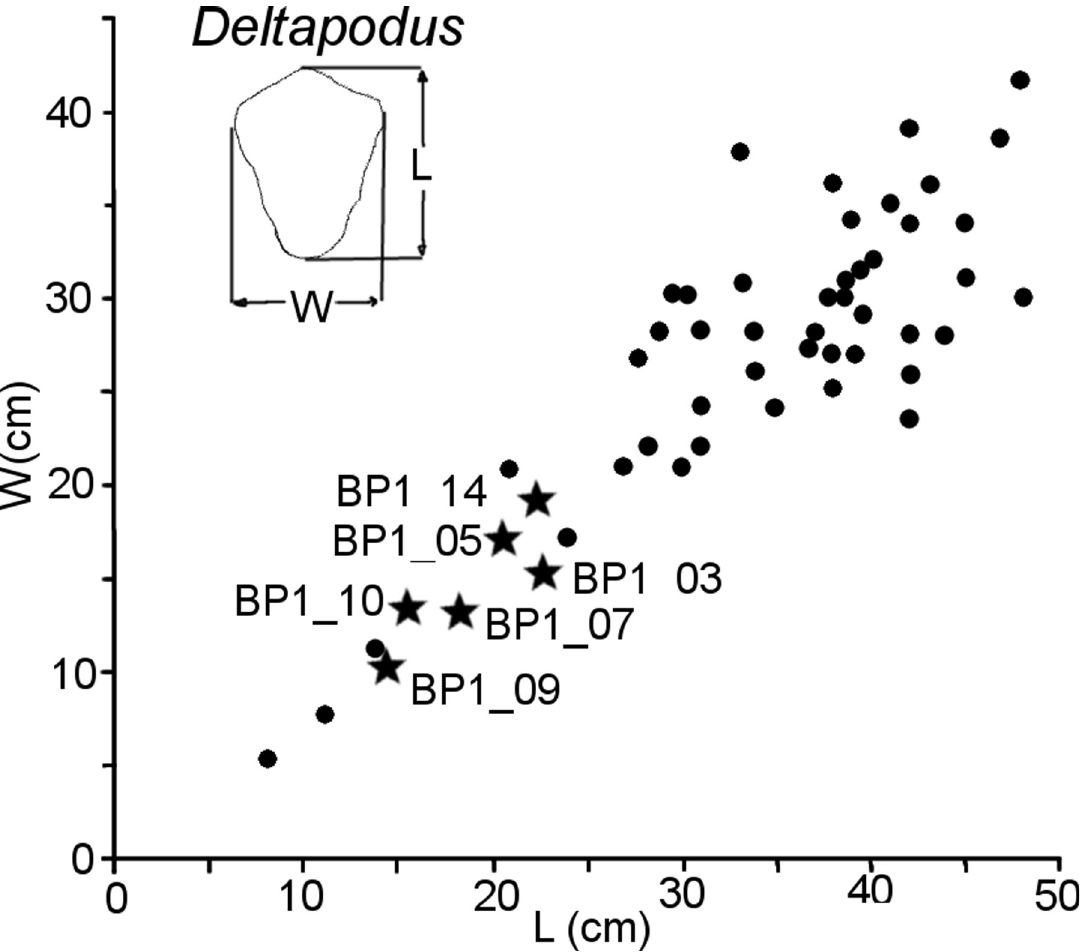
Fig 9. Relative sizes of Skye and Yorkshire Deltapodus tracks. The Skye quadrupedal tracks (shown as stars) are plotted with known Deltapodus track measurements from Yorkshire (redrafted and modified from Fig 13, [85]). All Skye tracks fall within the general size trends for the